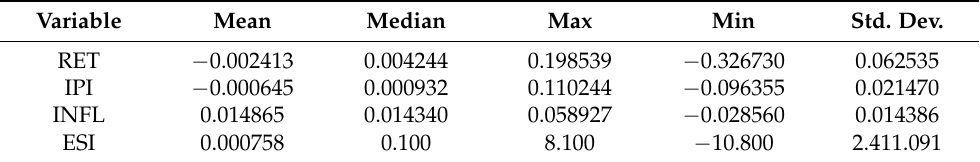
Table 2. Descriptive statistics for the full